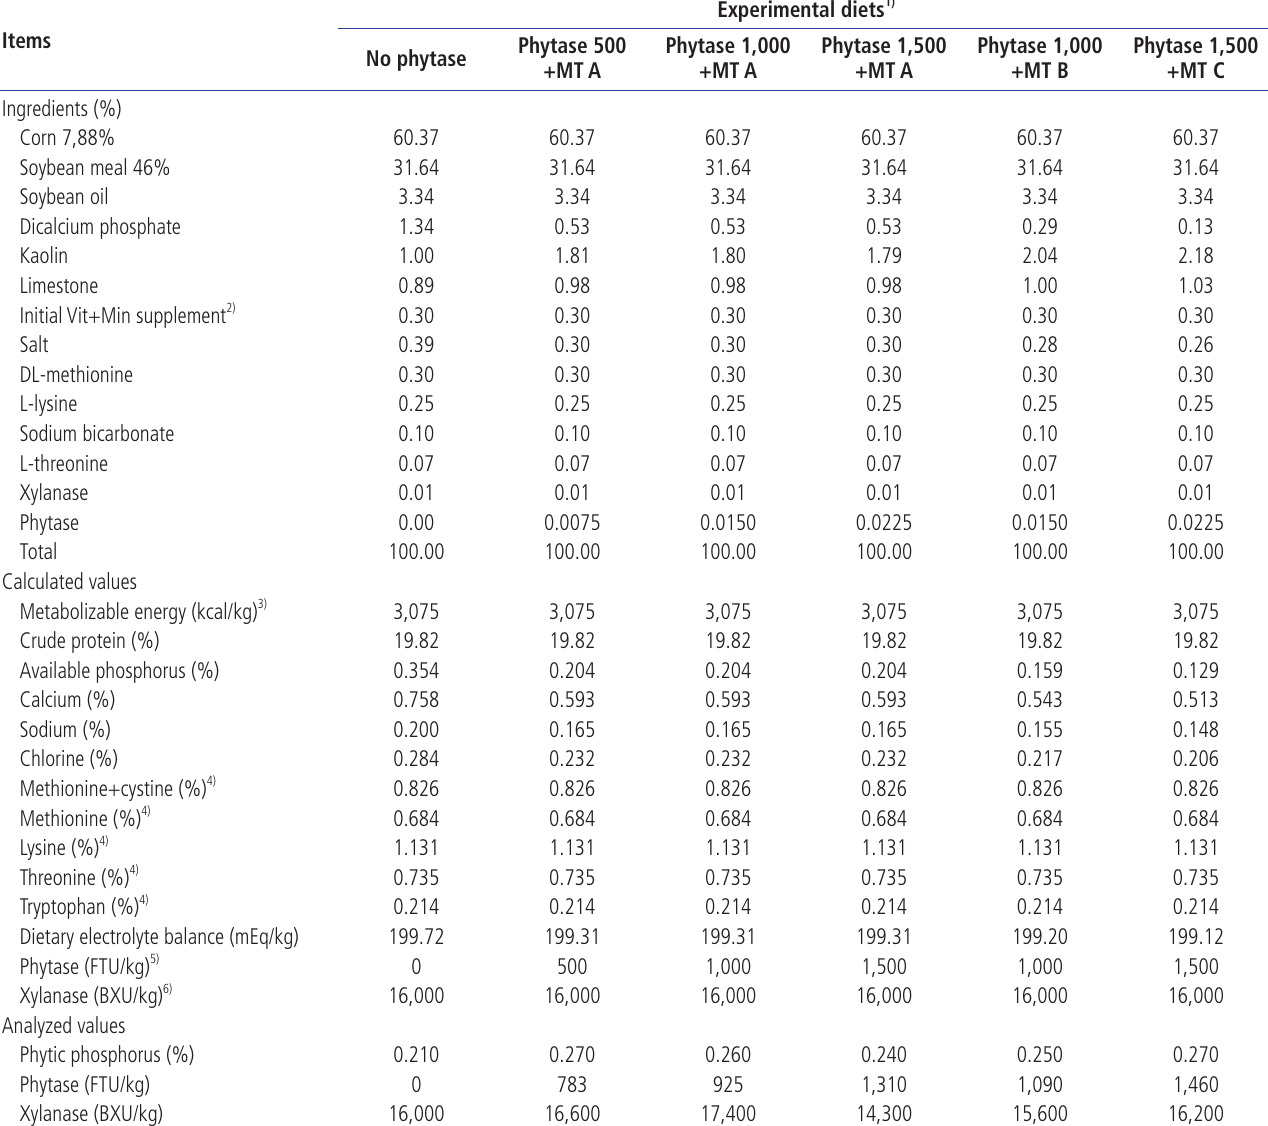
Table 3. Nutritional composition and calculated values of broiler experimental diets (22 to 33 days)